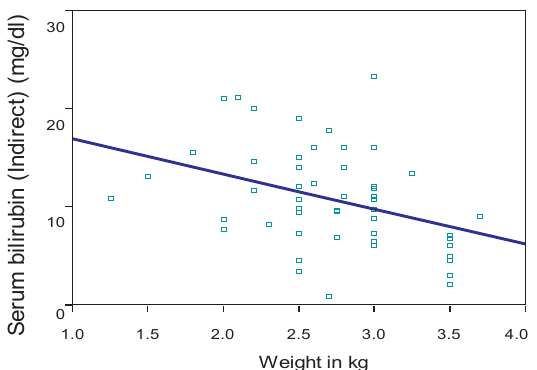
Fig 4. Correlation between birth weight and serum